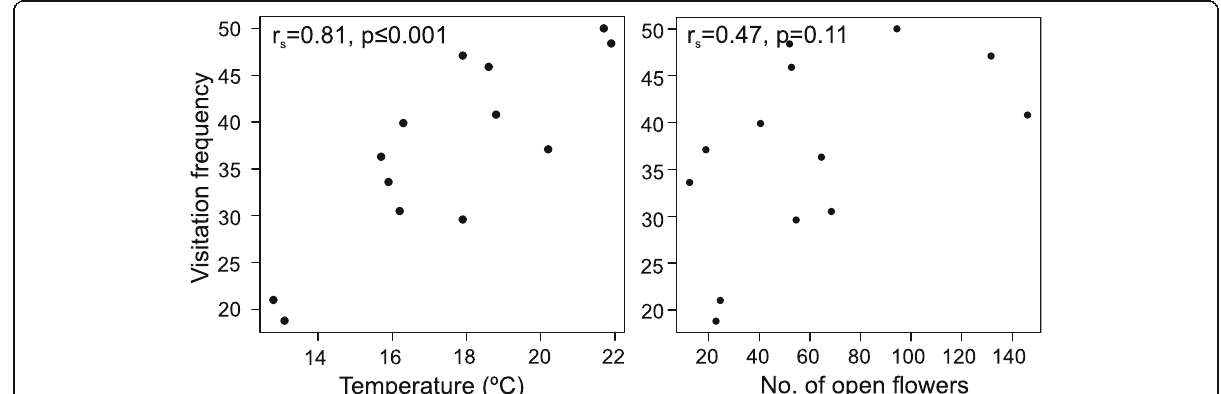
Fig. 5 Spearman rank correlation (r s ) between mean visitation frequency of visiting bees and temperature (left side graphic) and number of open flowers (right side